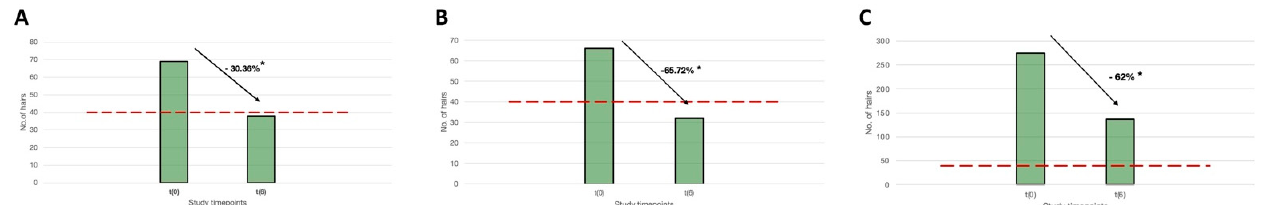
Figure 3. Tomorrowlabs [HSF] hair restoration significantly reduces hair loss. ( A ) The results of hair loss assessment via combing show a significant decrease in hair loss in the study group. The mean delta of hair loss across all study participants was − 30.36%, resulting in an average reduction of 38 hairs lost at t(6) vs. 69 hairs lost at T(0) (* p < 0.05). ( B ) For responsive participants, an average hair loss reduction of 66.8% was measured, corresponding to 37 hairs lost on average at t(6) (* p < 0.05). ( C ) Interestingly, we found that for the top 20% of the study participants suffering from the most active hair loss reflected by hair count at t(0), it was still possible to achieve a dramatic reduction in hair loss with an average improvement of more than 60% at t(6) (* p < 0.05). Average physiological hair loss depicted by red dashed line.